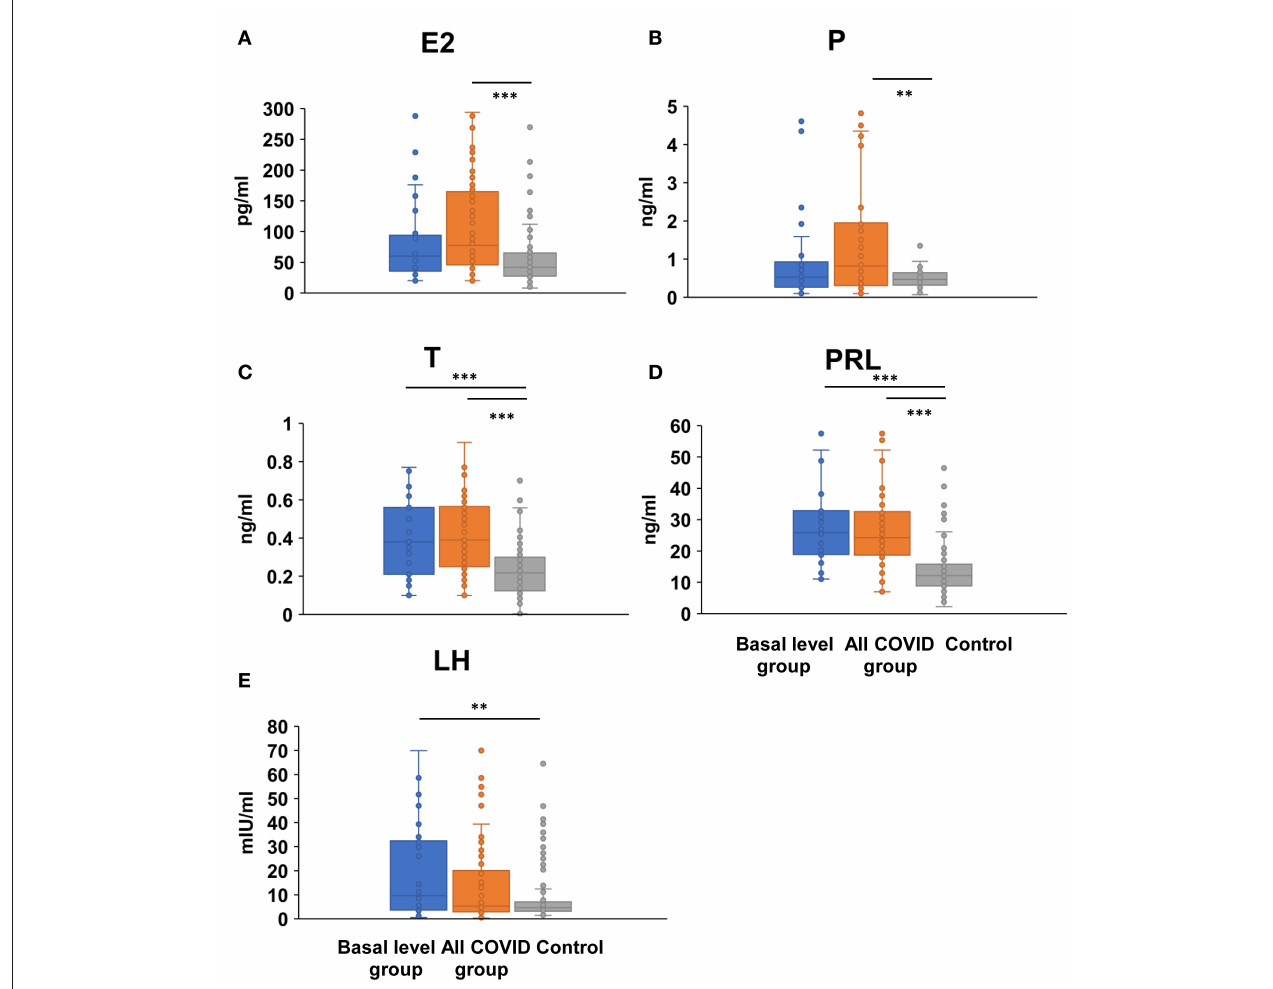
FIGURE 3 | Comparison of female sex hormones between COVID-19 patients and healthy women. Differences of serum E2 (A) , P (B) , T (C) , PRL (D) , and LH levels (E) were compared between basal level/all COVID-19 group and healthy control women; ** P < 0.01, *** P < 0.001. FSH/LH ≥ 2: 30.80 vs. 52.19%, P = 0.003) was